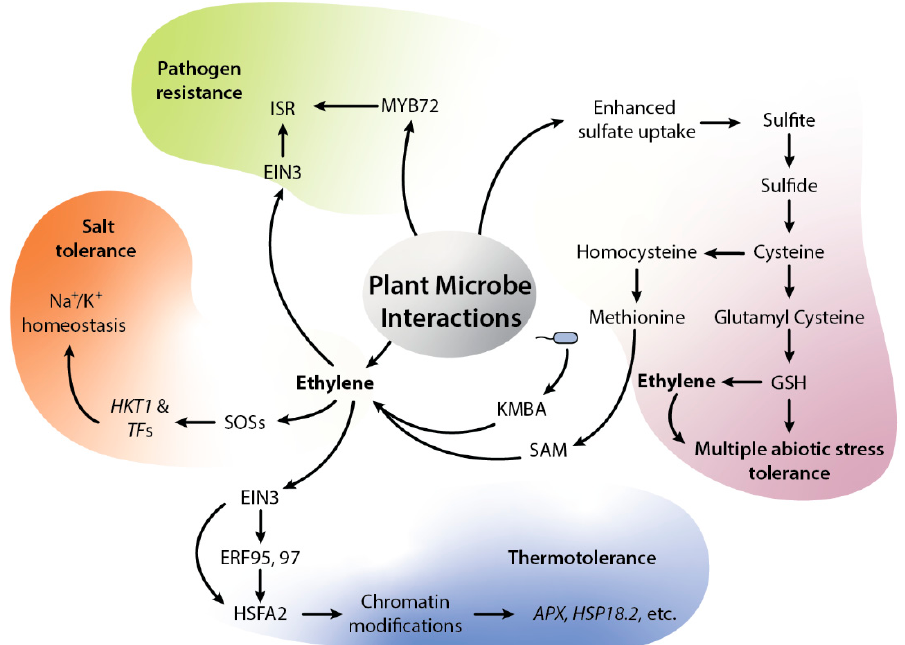
Figure 2. Diagrammatic representation of ethylene-mediated beneficial plant-microbial interactions. Microbes such as SA187 can trigger ethylene signaling via sulfur metabolism by uptake of sulfate, which further becomes converted into sulfite, sulfide, and cysteine. Further, cysteine can be used to generate either methionine or glutathione (GSH). GSH can be used in ROS scavenging, while methionine can regulate sulfur regulon via its conversion into SAM, ACC and ethylene. SA187 also produces KMBA, which plants can use to produce ethylene. In addition, KMBA contains sulfur